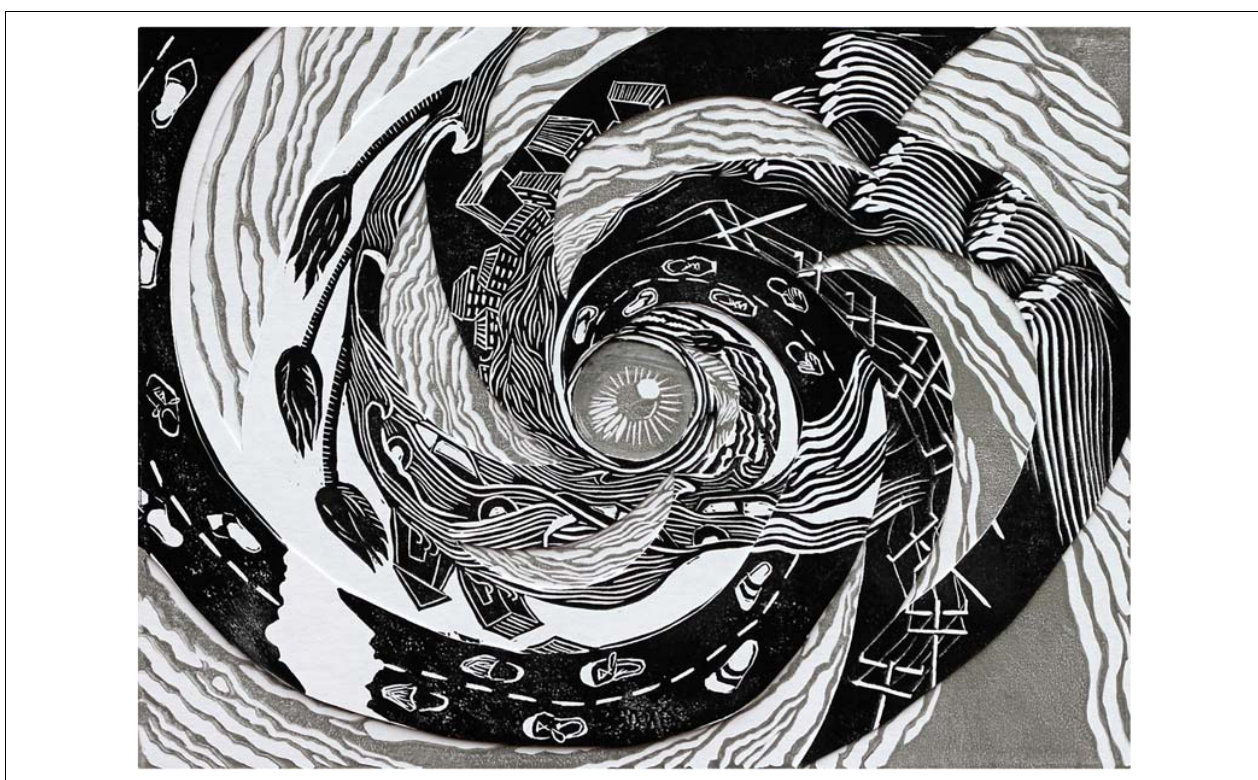
FIGURE 2 | Linocut by author Simona Clausnitzer that depicts the lived experience of hurricanes, in particular Hurricane María. The image can be interpreted literally, as a hurricane and its numerous impacts, or more symbolically: watching ourselves twist in a storm system of inequities that caused people living in Puerto Rico to be without power for as much as 328 days following María, largely due to a lack of support from the United States’ federal government. As severe weather events worsen in frequency and intensity, it is crucial to have meaningful justice-oriented climate legislation, much of which is being developed at